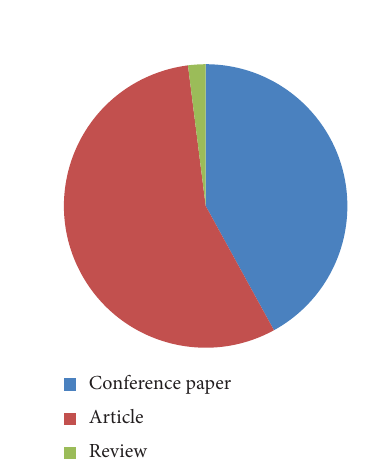
Figure 2: Composition of literature types